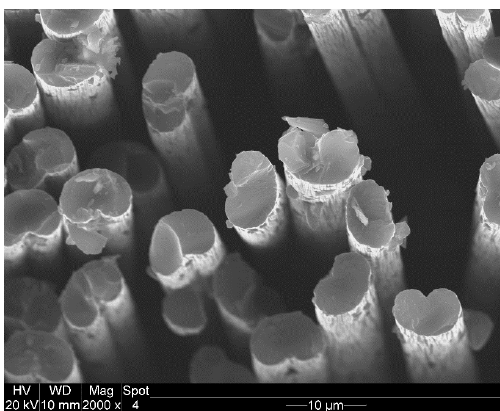
Figure 1. Kidney bean shaped carbon fibers under scanning electron microscope imaging.